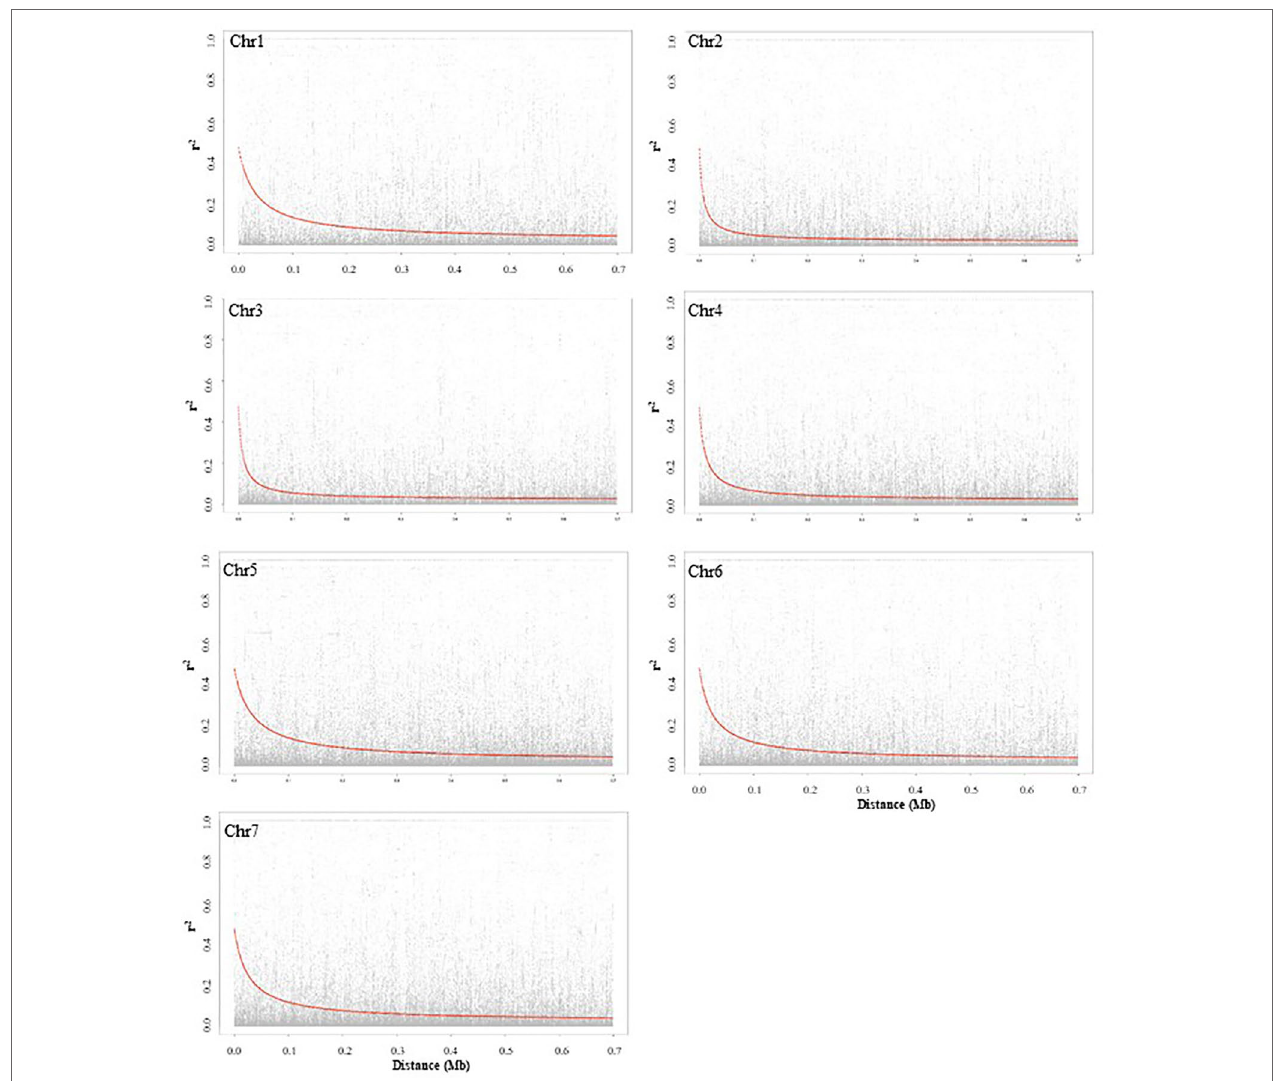
FiGUre 2 | Chromosome-wise linkage disequilibrium decay based on 135 pea accessions. The decline of LD- r 2 between SNPs pairs is presented as a function of physical distance in base pairs.